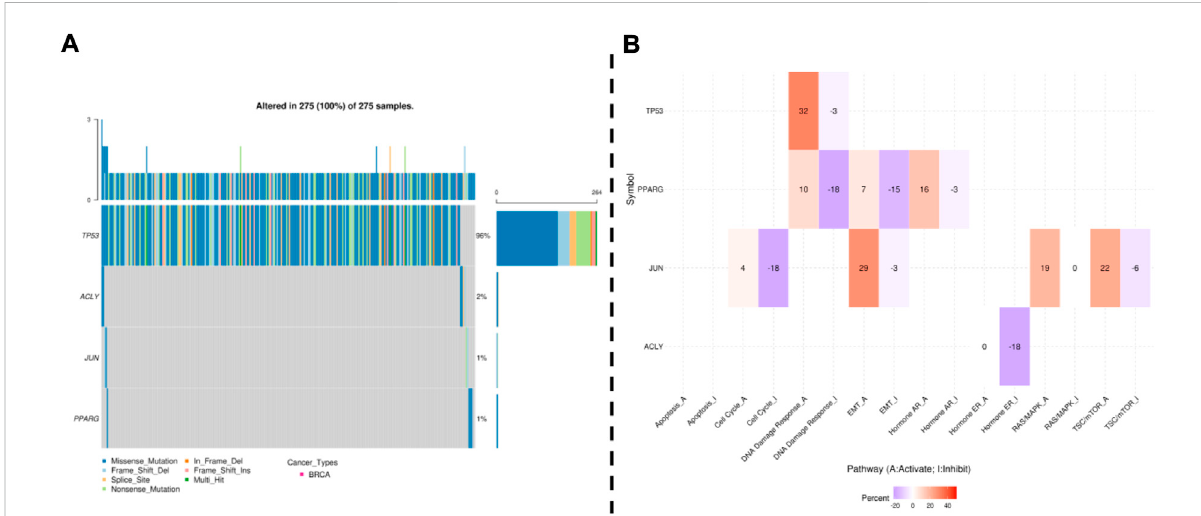
FIGURE 7 GSCA online databasewasselected to analyze thesinglenucleotide variation and pathway activityofvalidatedgenes. (A) :Waterfall plots,give a single nucleotide variation inBREASTgene sets. (B) :Effects ofthe validated geneon cell pathway activity, gene expression wasdivided into 2 groups (High and Low) by median expression, the difference of pathway activity score (PAS) between groups was de fi ned by student t -test, p -value was adjusted by FDR, FDR ≤ 0.05 was considered as signi fi cant. The pathway activity module presents the correlation of gene expression with pathway activity groups (activation and inhibition) that are de fi ned by pathway